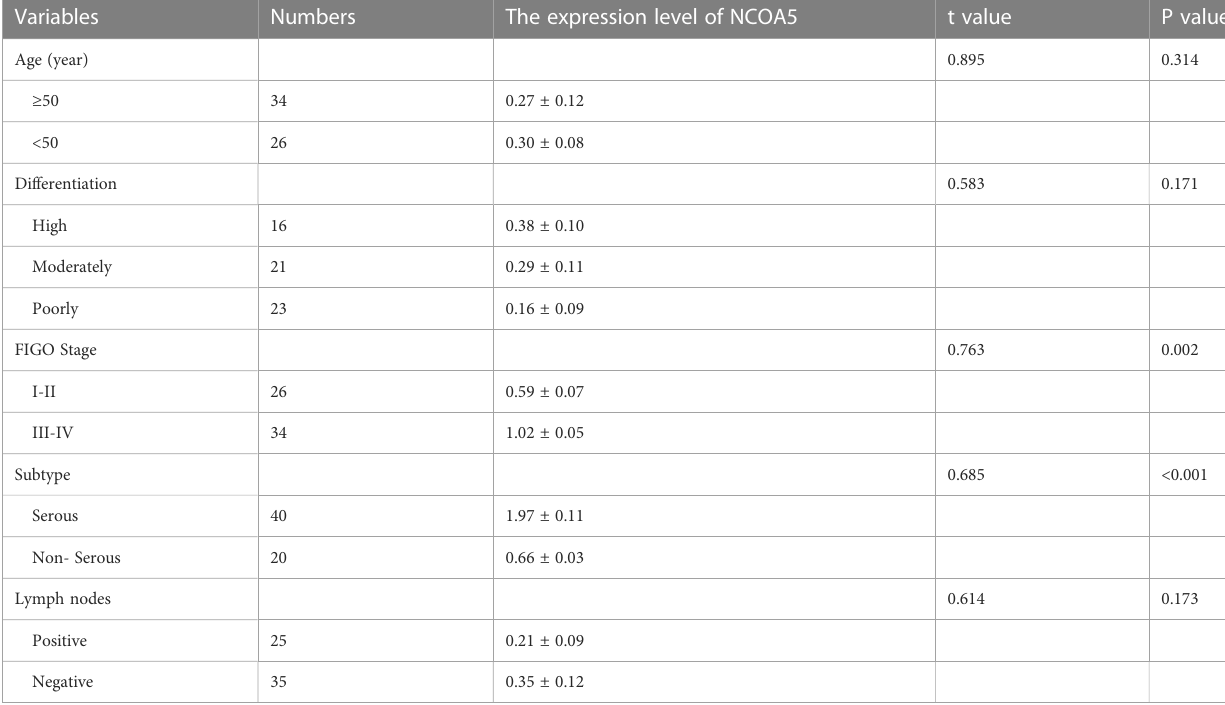
TABLE 2 The relationship of NCOA5 expression with EOC clinicopathological features (Pearson ’ s c 2 test).